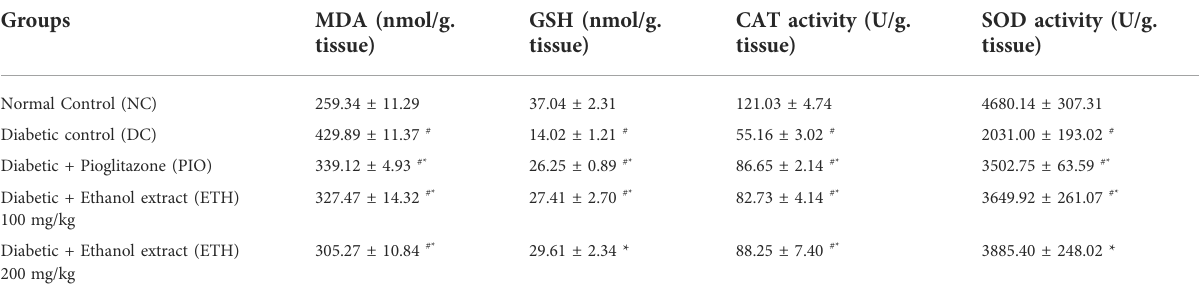
TABLE 3 MA ethanolic extracts increase the antioxidant enzymes ’ activity and decrease oxidative stress parameters.